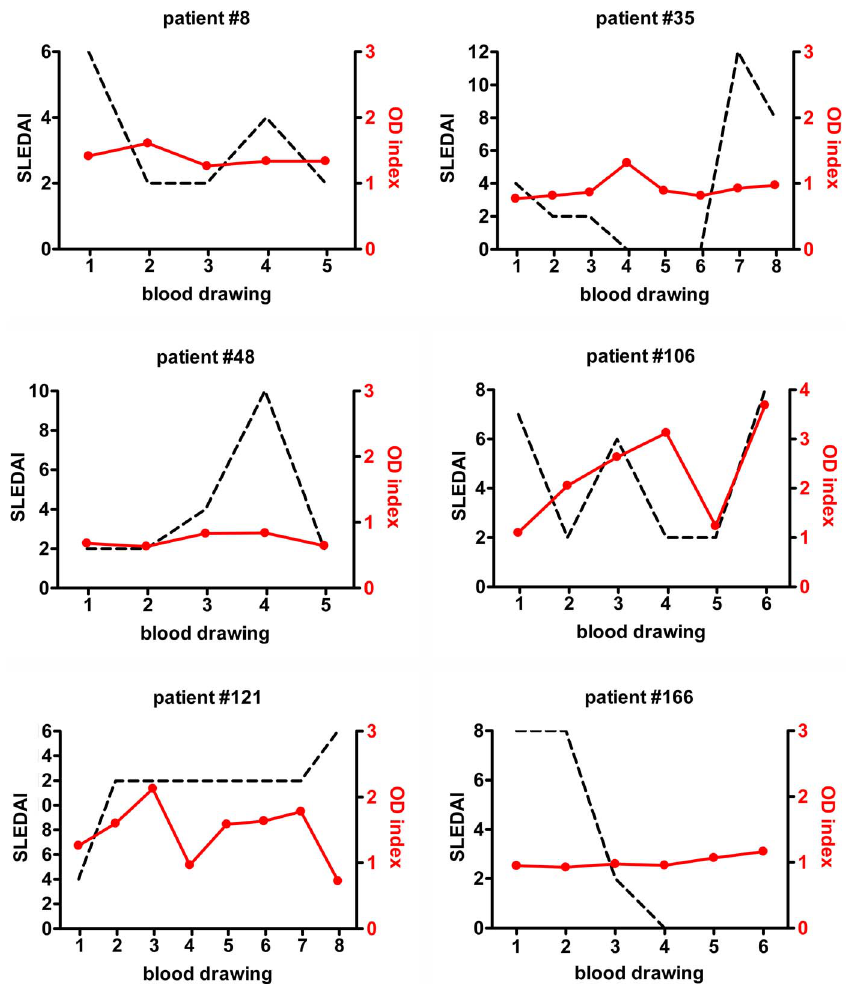
Fig. 2. Longitudinal follow up of SLE patients does not uncover an association of anti-LL-37 autoAbs and disease activity. Development over time of SLEDAI (dashed black line) and OD index of anti-LL-37 autoantibodies (red line) in 6 representative patients with SLE. A connection between anti-LL-37 and SLEDAI is not apparent.